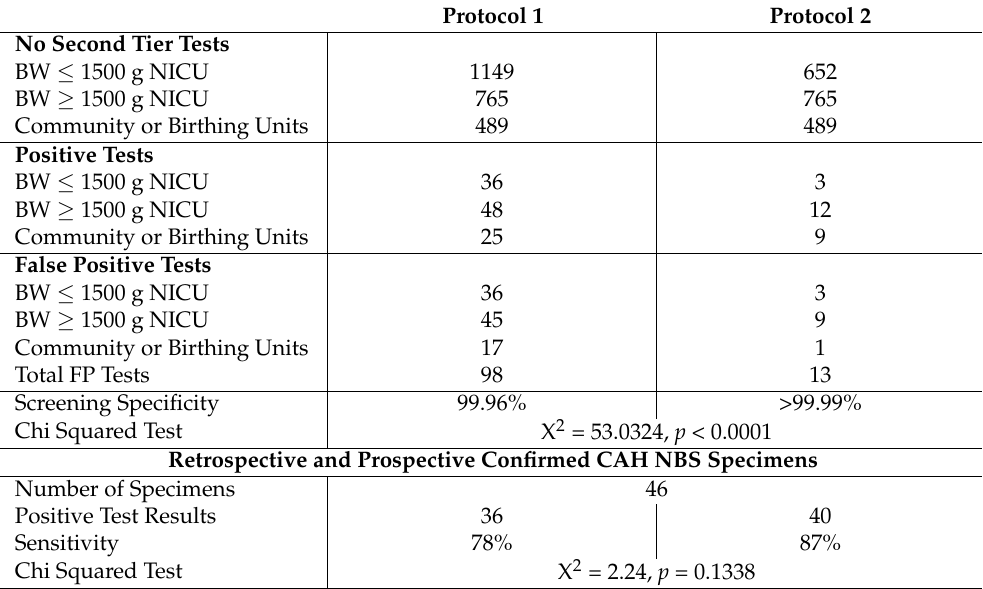
Table 3. Results for NBS for CAH in New Zealand (2018–2021) (Protocol 1) compared with modelling for Protocol 2. NICU: Neonatal Intensive Care